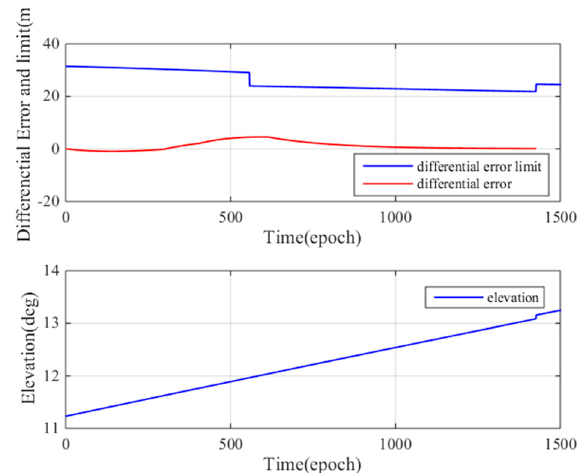
Figure 23. ( top ) Maximum differential error versus ionospheric gradient width at high satellite elevation; ( bottom ) satellite elevation.